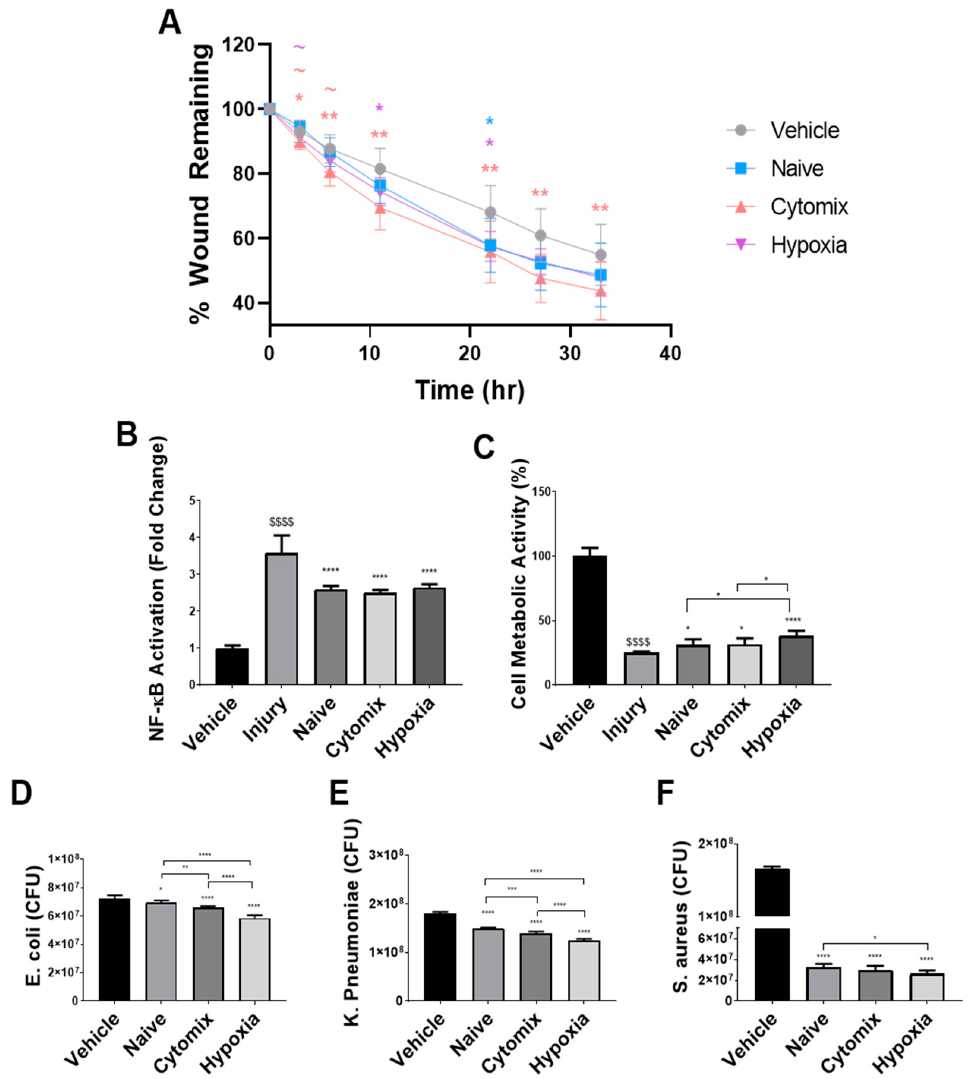
Figure 1. Pre-activated MSC-derived CM significantly increased the rate of wound healing ( A ) and attenuated the increase in inflammatory injuries induced by cytomix in A549s ( B ). Pre-activated MSC-CM also restored the decreased cell metabolic activity induced by peroxide injury ( C ) compared to the vehicle control. The application of conditioned media from naïve and pre-activated MSCs to cultures of bacteria significantly decreased the viable CFU of E. coli ( D ), K. pneumoniae ( E ), and S. aureus (F). CFU = colony forming units. All datapoint symbols represent individual datapoints, and columns represent means. Error bars represent SDs. * ,**, ***, **** = p ≤ 0.05, 0.01, 0.001, 0.0001 with respect to the vehicle control. $$$$ = p ≤ 0.0001 with respect to the sham group. N = 6–12. Treatment with both naïve and pre-activated MSC-CM reduced the inflammation in- duced by cytokine injury (Figure 1B) and LPS injury (Figure S1A) to a comparable degree, with hypoxia pre-activation only reducing TNF- α secretion on average (Figure S1A). All